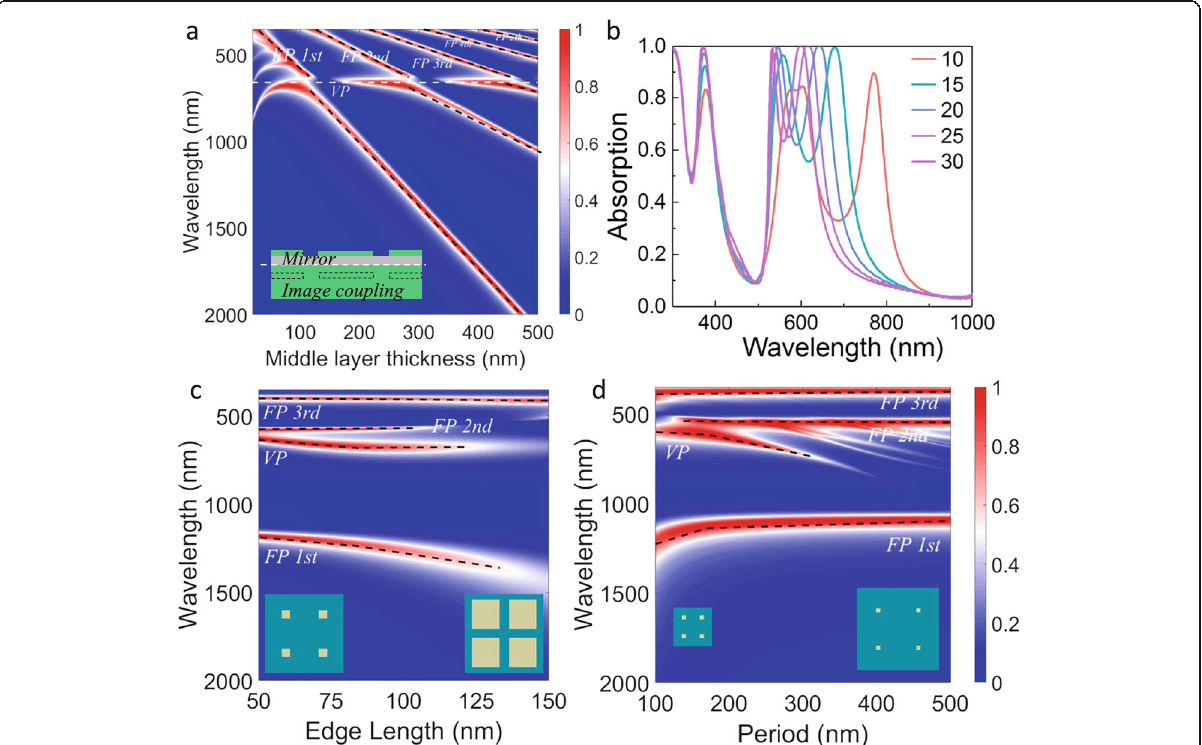
Fig. 5 a Calculated absorption contour for the proposed nanohole array-based absorber as a function of the wavelength and the spacer layer thickness h 2 . The black dashed line represents the FP resonance and the white dashed line represents the VP mode. The inset shows the images (the dash rectangles) of the top metal layer with respect to the mirror metal interface (the white dash line). b Calculated absorption of the proposed nanohole array-based absorber dependent on h 1 changing from 10 to 30 nm. c Calculated absorption contour for the proposed nanohole array-based absorber as a function of w with p = 200 nm. d Calculated absorption contour for the proposed